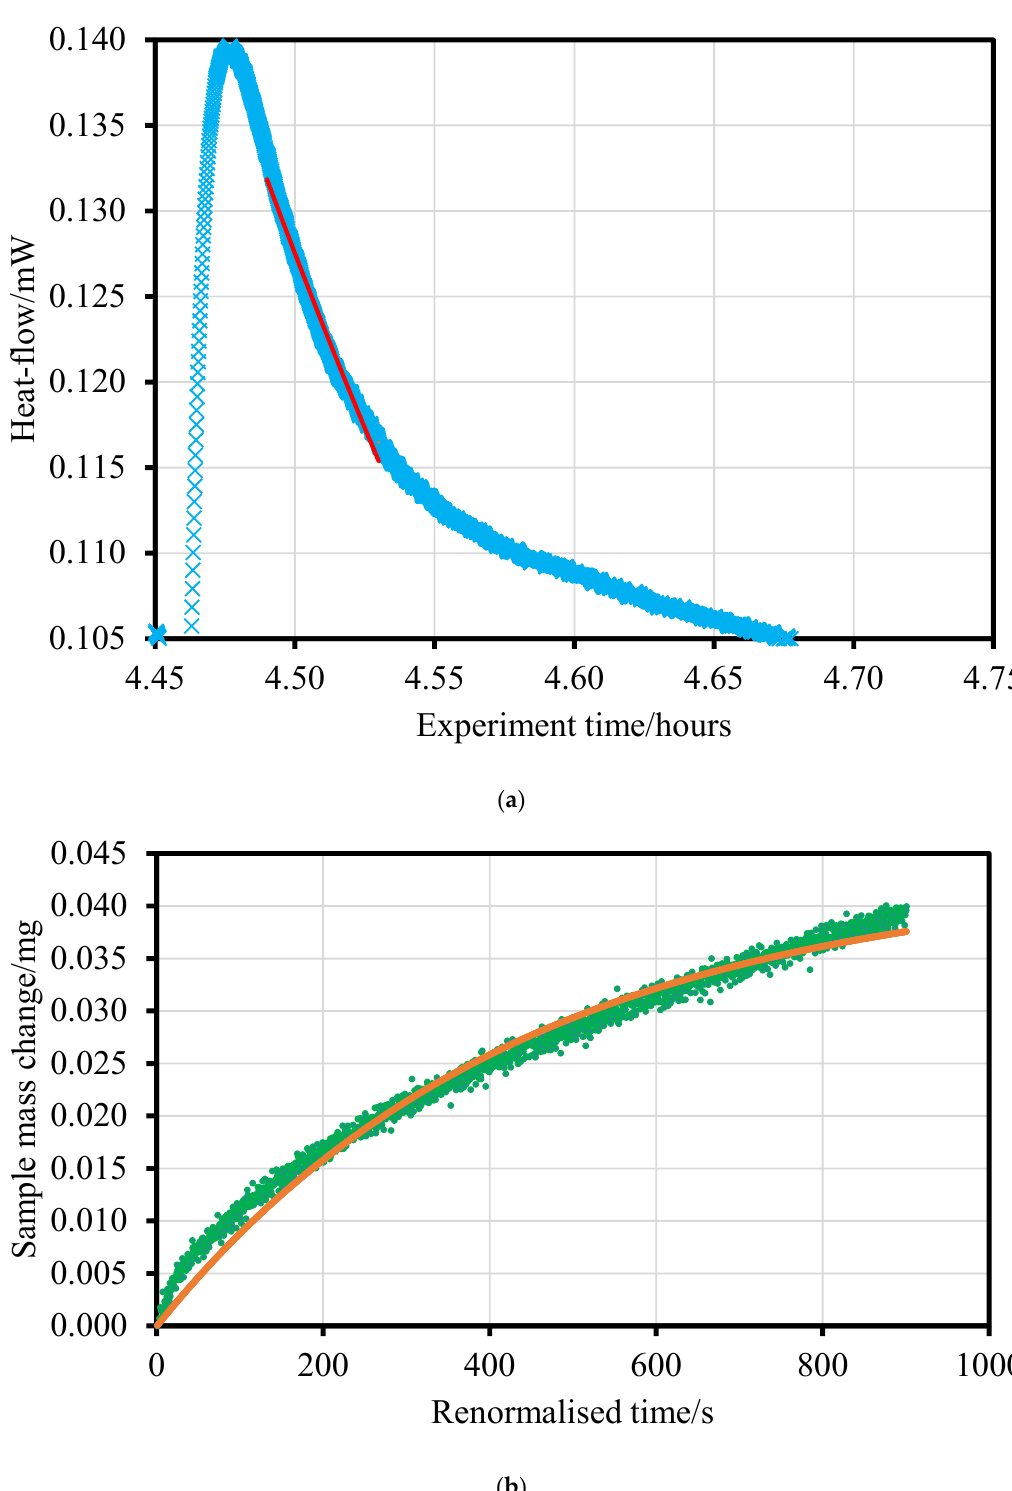
Figure 9. Typical raw datasets for a particular pressure point of the adsorption isotherm from an adsorption calorimetry experiment on a sample of Above Marine Band Bowland shale, showing heat-flow (( a ), blue crosses) and mass uptake (( b ), green squares). Also shown (solid red lines) are fits of the experimental data to an exponential decay function ( a ) and the LDF model ( b ).